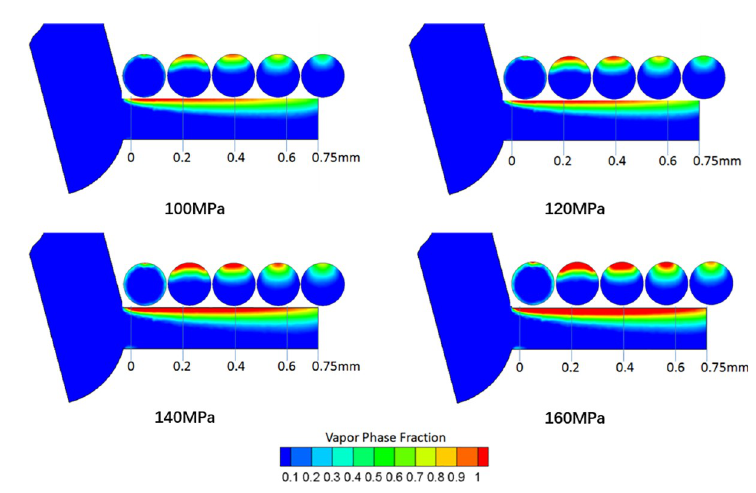
Fig 7. Contour of vapor volume fraction against different P